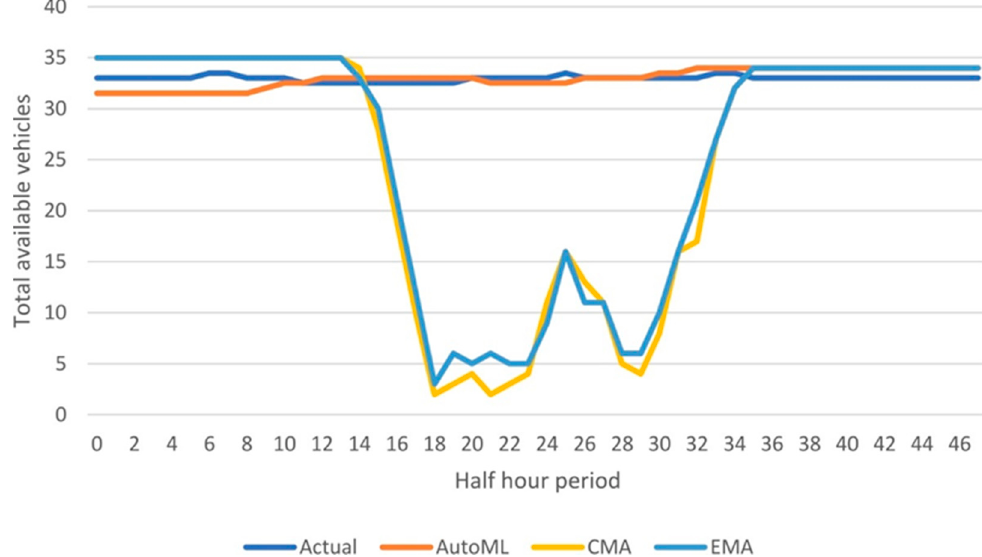
Figure 4. Total available vehicles predicted by the 3 models for the 2 holiday Mondays in the test dataset compared to actual availability.